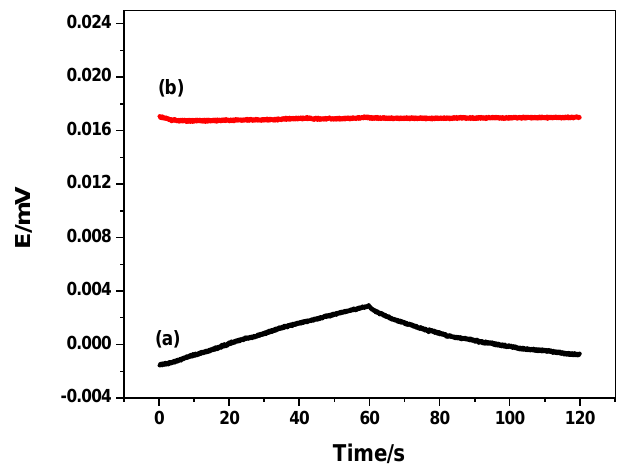
Figure 5. Chronopotentiogram for ( a ) C/harmine-ISE; and ( b ) C/PEDOT:PSS/harmine-ISE. Figure 5. Chronopotentiogram for (a) C/harmine-ISE; and (b) C/PEDOT:PSS/harmine-ISE. Impedance measurements were carried out for both C/PEDOT:PSS/harmine-ISE and C/harmine-ISE. The impedance spectra were recorded at the open-circuit potential in 10 mM HMR solution and are shown in Figure 6. From the high-frequency semicircle part, the total resistance (R) was found to be 0.25 ± 0.03 and 0.18 ± 0.04 M Ω for both C/PEDOT:PSS/harmine-ISE and C/harmine-ISE, respectively. The capacitance ( C ) for ei- ther C/PEDOT:PSS/harmine-ISE or C/harmine-ISE was estimated from the